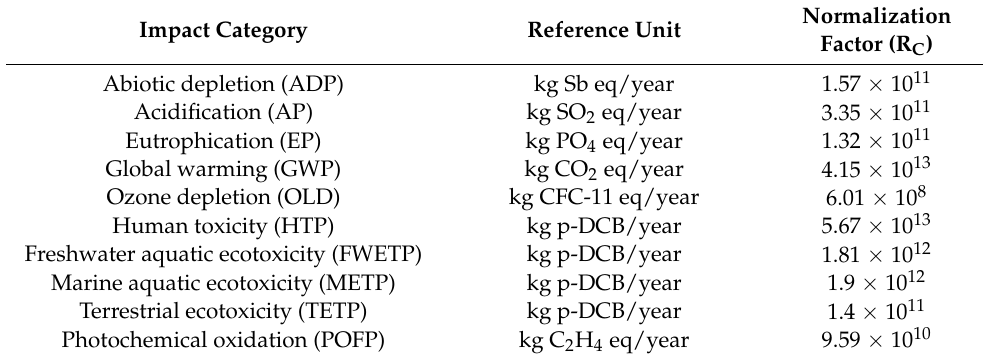
Table 7. Normalization factor of the world in 1995 [29].